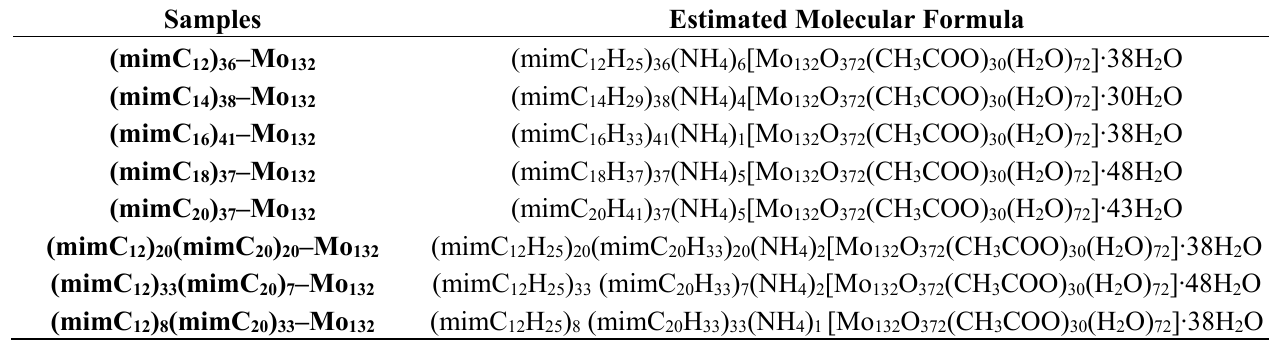
Table 1. Molecular formula of the Mo 132 -based materials established from elemental analysis and